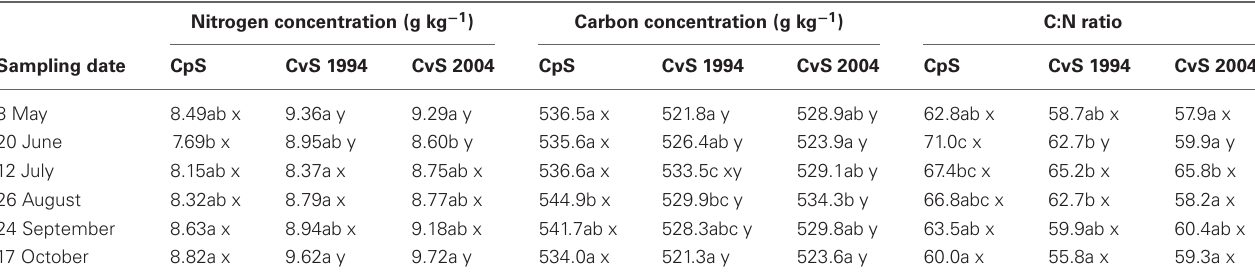
Table 2 | Estimated marginal mean values (means adjusted for soil-depth and diameter class covariates, N = 36) of fine-root nitrogen and carbon concentration and C:N